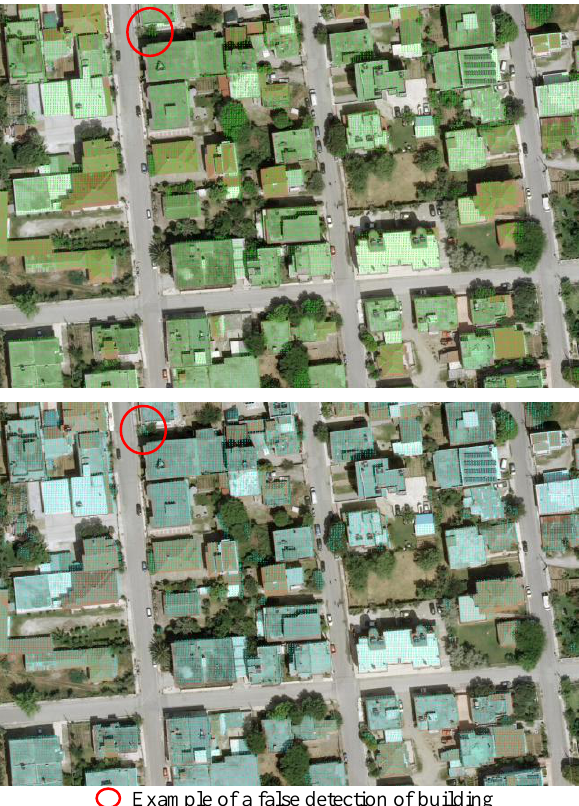
Figure 6. Final point cloud of buildings superimposed on an orthoimage, using the classification process in LAStools coloured in green (top); the classification process in ERDAS IMAGINE coloured in cyan (bottom) using the LIDAR point